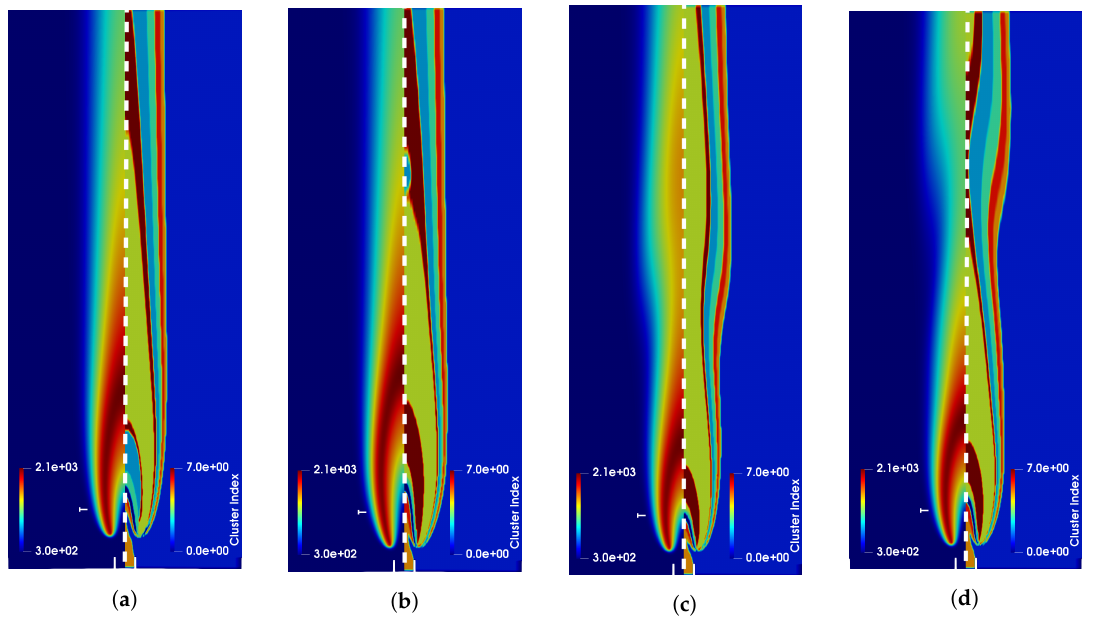
Figure 1. Maps of temperature (left part of each contour, in Kelvin) and example of the corresponding thermochemical space partitioning (right part of each contour) for timesteps of an unsteady 2D laminar coflow flame adaptive simulation: ( a ). t = 0.0025 s; ( b ). t = 0.04 s; ( c ). t = 0.09 s; ( d ). t = 0.12